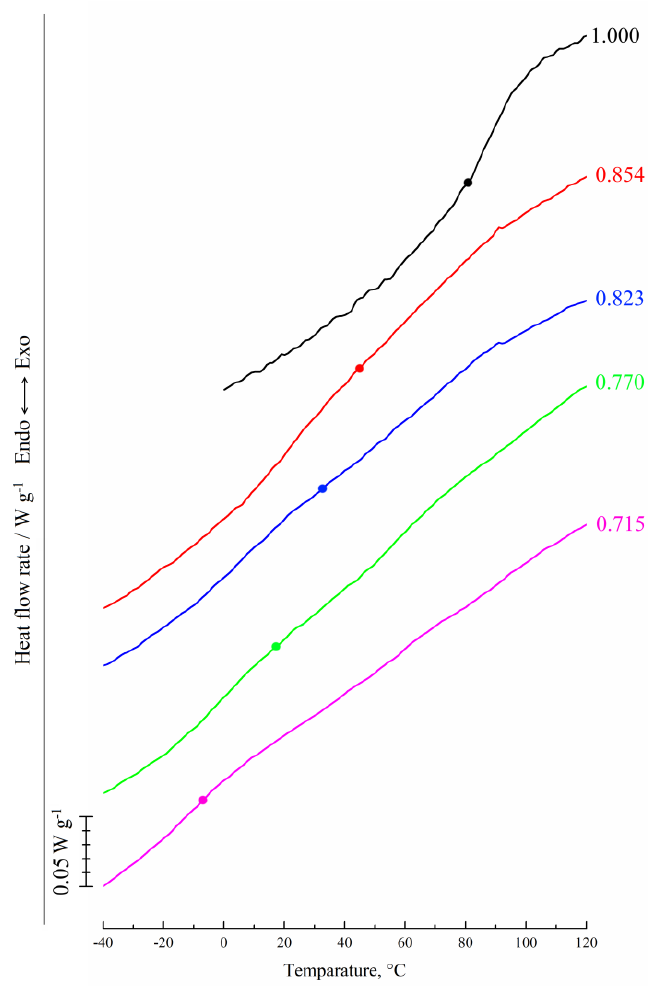
Figure 4. DSC thermograms obtained in the cooling mode for mixtures of PAN with NMP of various compositions. The mass fraction of the polymer in the mixture is indicated to the right of the curves. In cooling mode, the temperature T g corresponding to the middle of the glass transition step decreases with an increase in the amount of NMP in the mixture with PAN from 0.146 to 0.285 g / g . At a higher NMP content in the mixture, glass transition was not observed. Similar tendencies were also observed for a ternary mixture of PAN with NMP and water of various compositions. The comparison of the glass transition temperature curves at different water content reveals that T g for PAN decreases as a result of NMP presence while the addition of water reduces this effect (Figure 5). The coordinates of the intersection of these curves with the horizontal isotherm corresponding to T = 25 ◦ C were used to plot the BC fragment of the polymer glass transition line on the ternary phase diagram for PAN mixtures with NMP and water (Figure